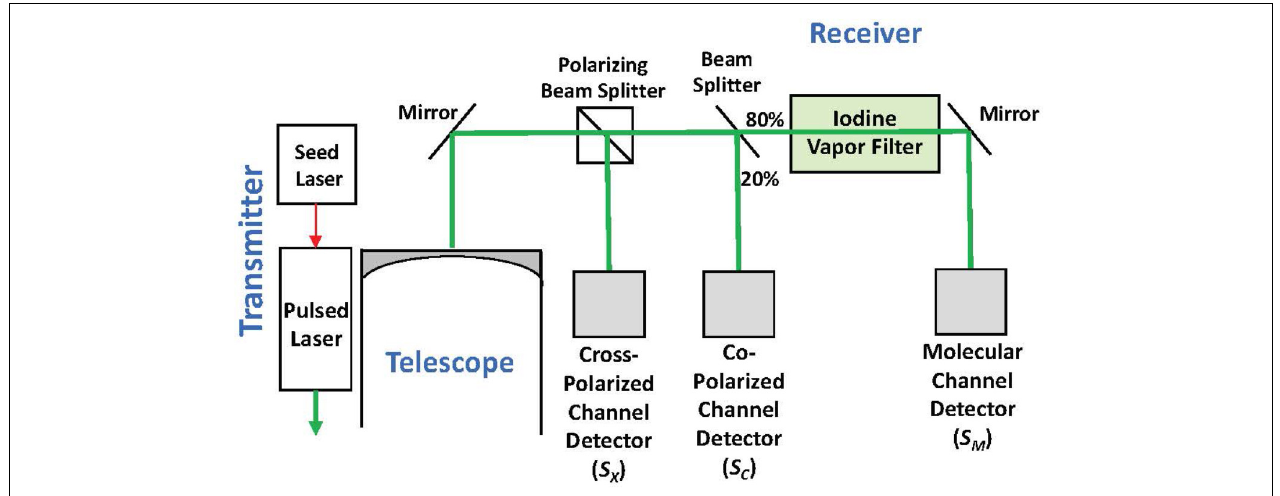
FIGURE 2 | Simplified block diagram of the HSRL-1 instrument deployed on the NASA C-130 aircraft for the NAAMES mission.